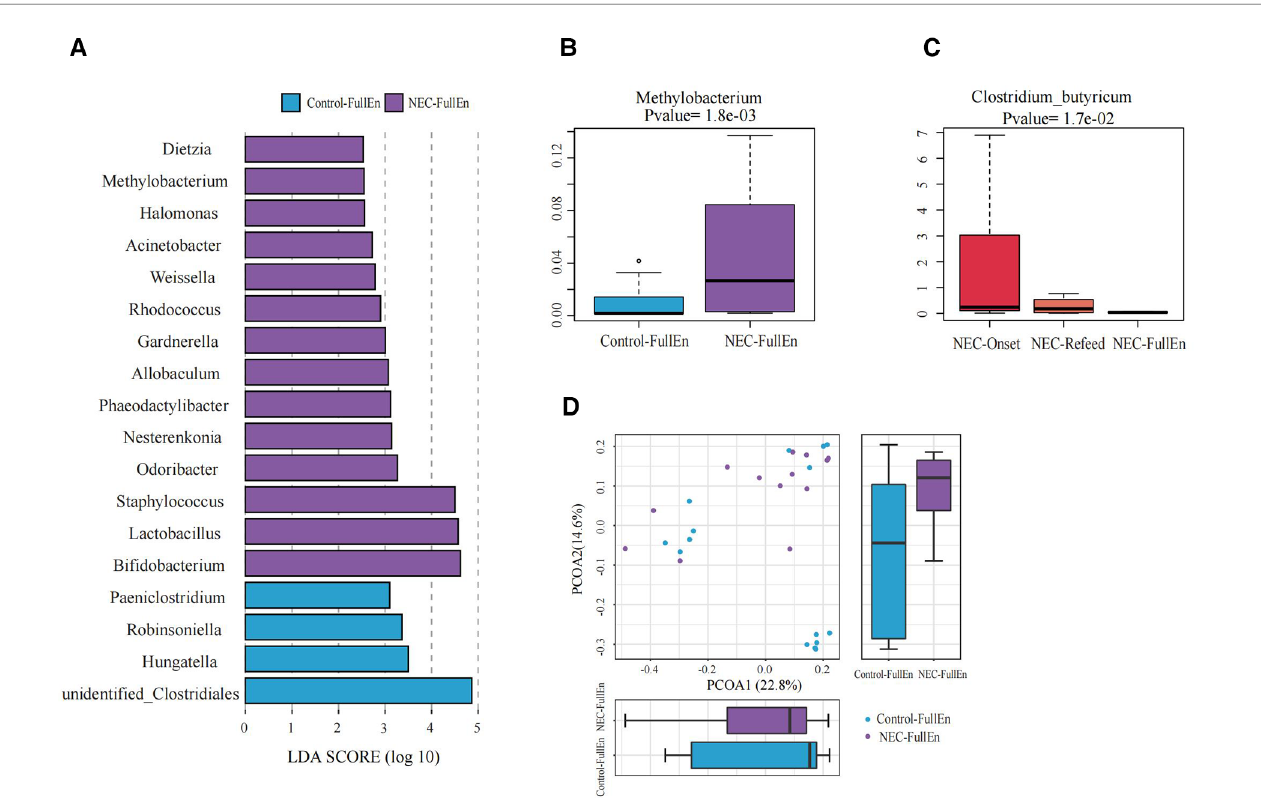
FIGURE 4 Signi fi cant differences in the microbiota and correlation. ( A ) Gut microbiota analysis at the genus level using the LDA score between two groups after they achieved full enteral nutrition. ( B ) Bar chart of Methylobacterium between the NEC_FullEn group and the Control_FullEN group. ( C ) Bar chart of Clostridium_butyricum among the three subgroups of NEC. ( D ) Principal coordinate analysis (PCoA) of the microbial communities of the two groups after achieving full enteral nutrition. The microbiota cluster in the infants of the NEC_FullEn group (purple circle) and the Control_FullEn group (blue circle) was examined by using PCoA. NEC, necrotizing enterocolitis; LDA, linear discriminant